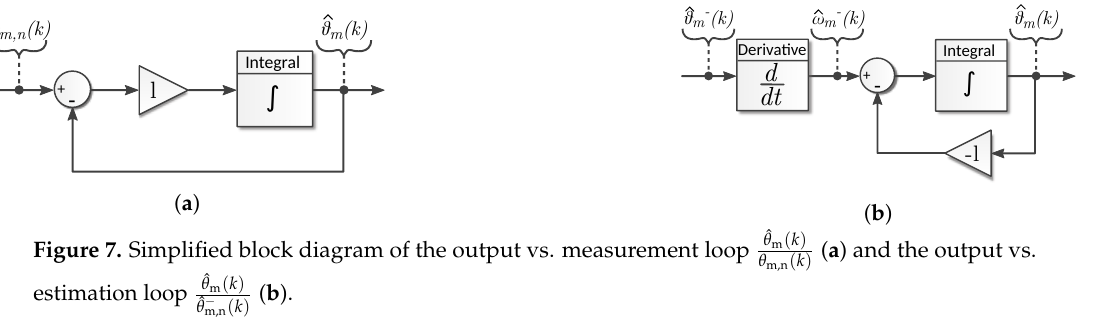
ˆ θ m ( k ) ( b ˆ θ − m,n ( k )